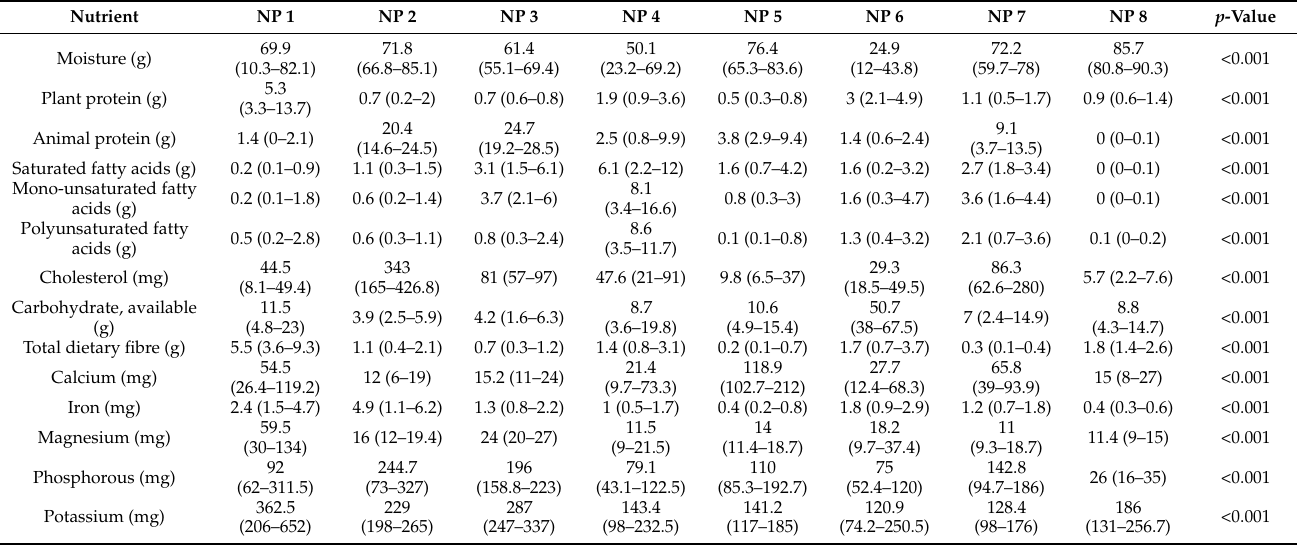
Table A2. Median (IQR) nutrient values by nutrient pattern